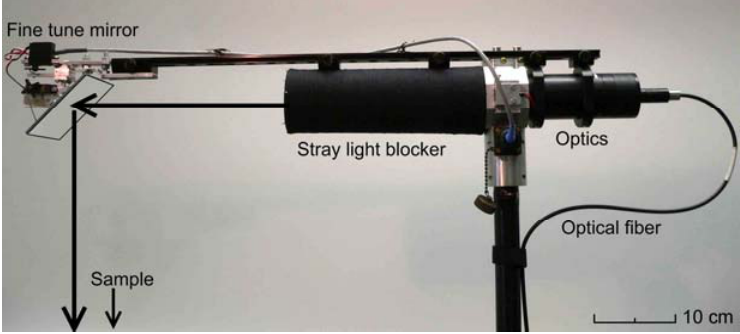
Figure 3. Optical system of FIGIFIGO. The spectrometer optical fibre is connected to the changeable optics. The optics point to the sample through a fine tune mirror. The mirror system allows the computer to fix the optics footprint to selected target without parallax